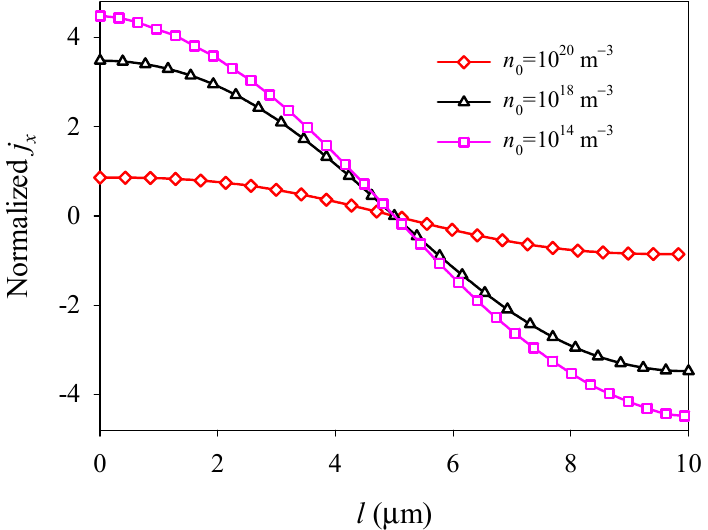
Figure 10. Normalized surface electric current density j x along the midline y = d/ 2 versus initial electron concentration n 0 .